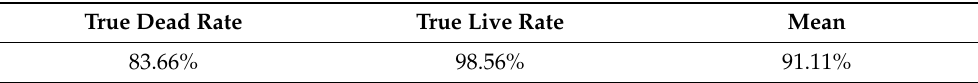
Table 11. Final results of the full classification method with the validation data.